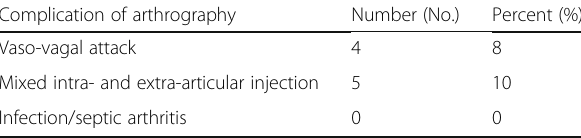
Table 5 Percentage of complications of the arthrographic procedure